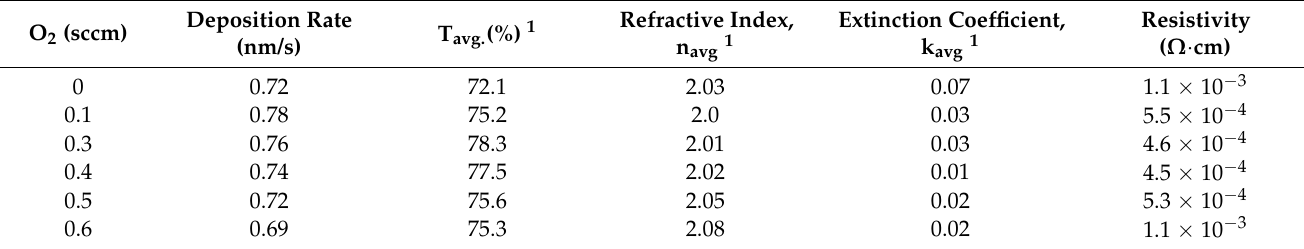
Table 2. Optical and resistivity properties of ITO films by changing O 2 flow rates.